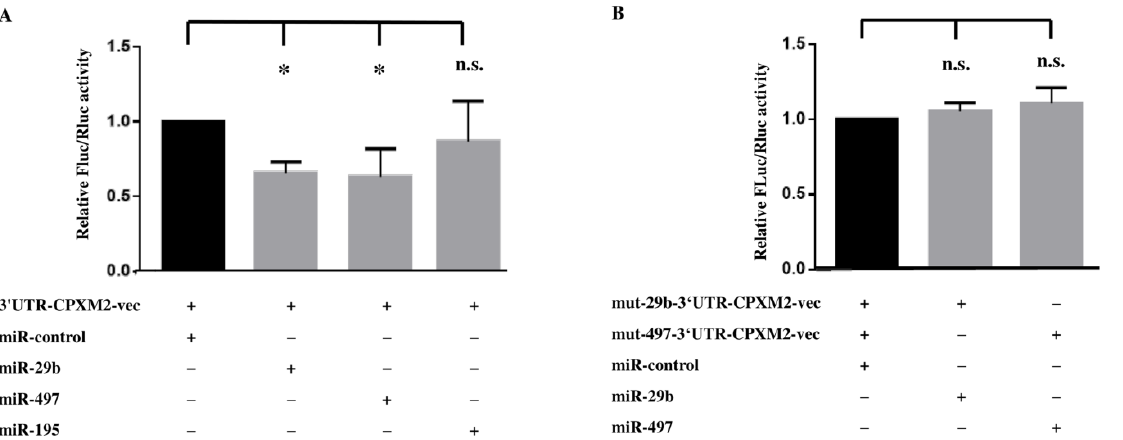
Figure 5. Dual luciferase reporter assay in H9C2. ( A ) Shown is the influence of miR-29b, miR-497, and miR-195, respectively, on the relative firefly luciferase activity of the miRNA 3′ UTR target clone pEZX-MT06, containing the 3′ UTR of CPXM2 ( 3′ UTR-CPXM2-vec) 48 h after transfection. ( B ) Depicts the impact of miR-29b and miR-497 on the relative firefly luciferase activity, respectively, containing the 3′ UTR of CPXM2 with mutated binding sides for miR-29b (mut-29b- 3′ UTR-CPXM2-vec), or miR-497 (mut-497- 3′ UTR-CPXM2-vec), respectively, 48 h after transfection. Firefly luciferase activity was normalized against renilla luciferase activity. (*) p < 0.05; (n.s.) no significant difference; n ≥ 3; FLuc, firefly luciferase activity; RLuc, renilla luciferase activity; miR-control, negative control miRNA mimics.